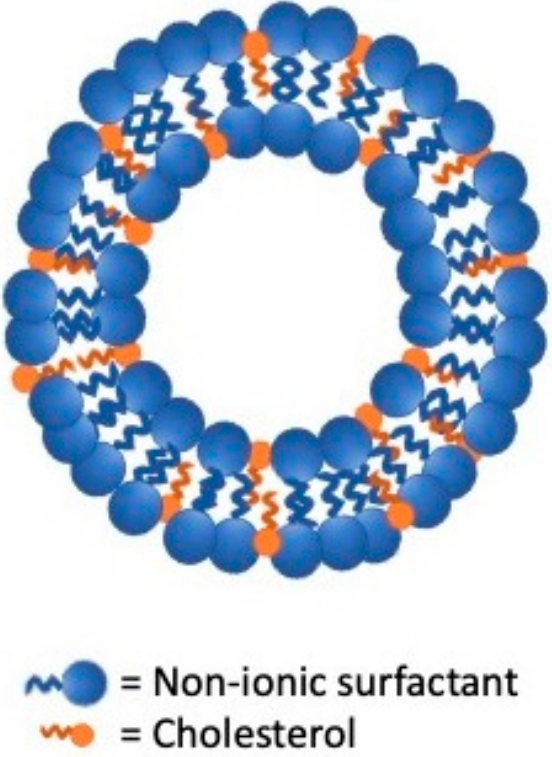
Figure 1. Structure of proniosomes lipid vesicular systems.